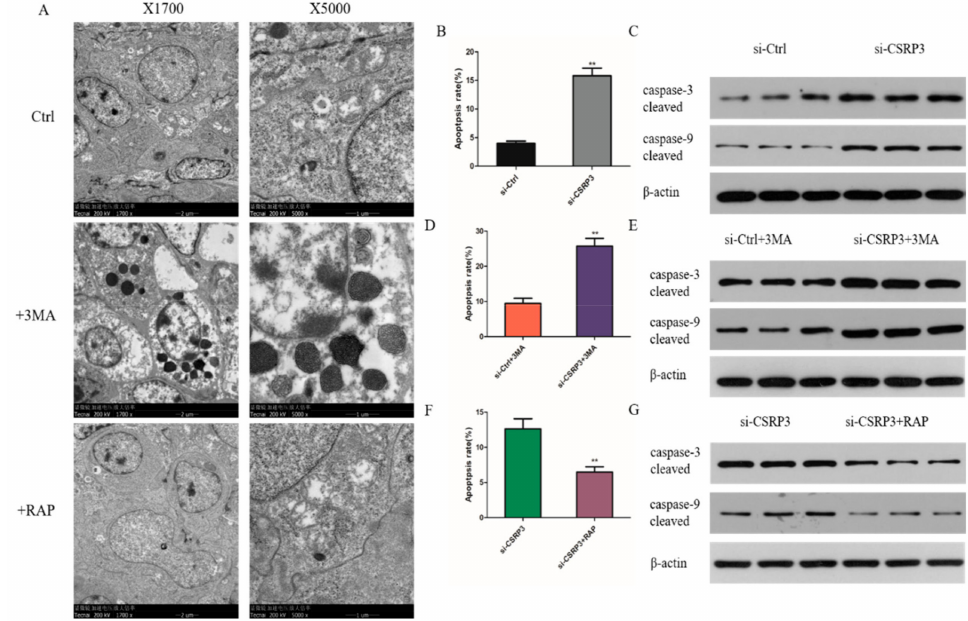
Figure 6. CSRP3 silence promotes cell apoptosis. ( A ) The ultrastructure of cells treated with 3MA, RAP or DMSO (ctrl) was observed by transmission electron microscopy. ( B ) Flow cytometry showed the apoptosis rates in control and CSRP3 siRNA cells. ( C ) The cleaved of caspase-3 and caspase-9 protein levels in control and CSRP3 siRNA cells. ( D ) Flow cytometry showed the apoptosis rates in control and CSRP3 siRNA cells incubated with 3MA. ( E ) Western blot analysis cleaved caspase-3 and caspase-9 protein levels in controls and CSRP3 siRNA cells incubated with 3MA. ( F ) Flow cytometry showed the apoptosis rates in control and CSRP3 siRNA cells untreated or treated with rapamycin (RAP). ( G ) The cleaved of caspase-3 and caspase-9 protein levels in CSRP3 siRNA cells untreated or treated with RAP. Data are expressed as mean ± SEM of three independent